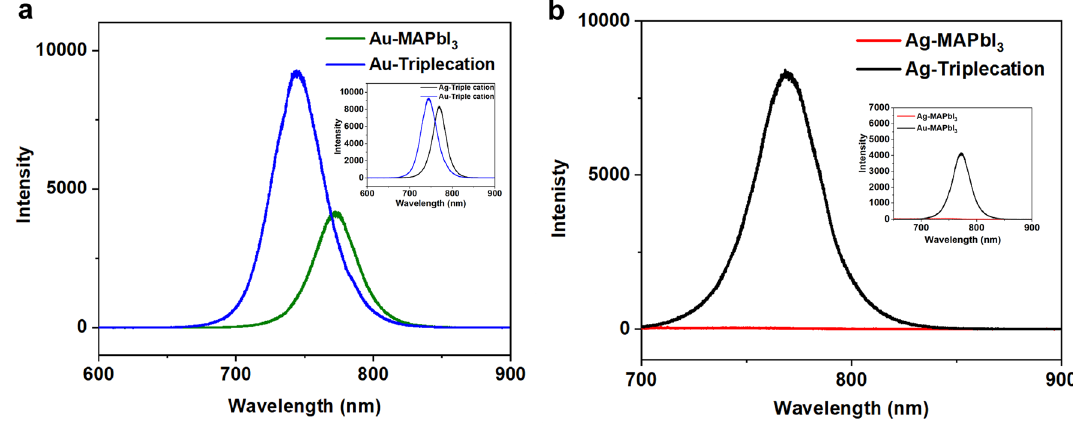
Figure 6. The PL spectra acquired using a 532 nm excitation laser, as it probed the absorber in situ within the solar cell stack in the n-i-p device architecture directly. ( a ) PL spectra of aged triple cation and MAPbI 3 based PSCs, where the cells were stored in ambient conditions for ~ 10 days in a petri dish without encapsulation at 25 °C and RH ~ 30 to 40% with Au electrodes. Inset represents peak shift between the Ag and Au based triple cation based perovskite. ( b ) PL spectra of aged triple cation and MAPbI 3 based PSCs with Ag electrodes. Inset represents the peak-shift between the Ag and Au-contacted MAPbI 3 within the solar cell stack. As shown in ( a ), PSCs with Au electrodes showed notable PL emission with a clearly visible peak maxima, which validates that both absorbers in Au-based PSCs are less vulnerable to degradation even with the formation of AuI. On the other hand, MAPbI 3 based PSCs in ( b ) showed a negligible PL peak over the same triple cation-based PSCs contacted with the Ag, which further supports the possible rapid degradation of MAPbI 3 based PSCs with Ag electrodes over the triple cation-based PSCs since the absorber in the former appears to be optically degraded through these in situ PL measurements to access the absorber layers for the degradation study mediated via the Ag and Au collector